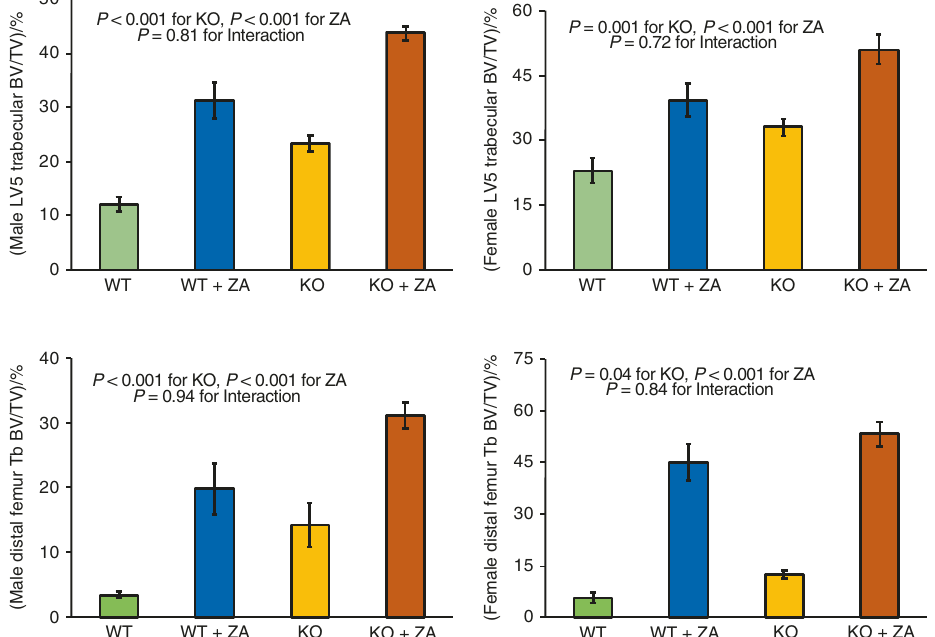
Fig. 5 Effects of Sfpr4 KO and zoledronic acid (ZA) treatment on trabecular bone parameters. Mice were dosed intraperitoneally with saline or zoledronic acid (20 μ g·kg − 1 ) at 8 weeks of age. Male and female mice were examined at 68 and 24 weeks of age, respectively. Data are means ± SEM for 5 to 8 mice per group with statistical analysis by two-factor ANOVA separate the sphenoid, ethmoidal and basioccipital bones at the Mouse clavicles, ribs, digits, and the cranial base, sites with base of the skull. 44 Presumably, disturbances in metaphyseal bone radiographic abnormalities in Pyle ’ s subjects, have not been examined as all mouse studies were performed prior to the 2016 modeling similar to those observed in limbs is responsible for identi fi cation of SFRP4 mutations being responsible for Pyle ’ s cranial base sclerosis observed in Pyle ’ s disease subjects. Skull disease. 9 During development growth plates (synchondroses) shape appears normal as SFRP4 does not affect longitudinal